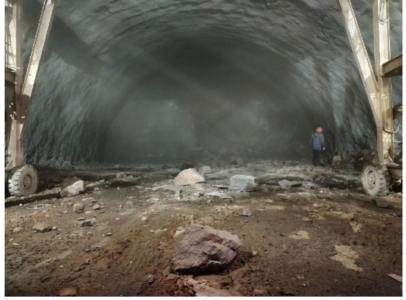
Figure 9. The distribution of rock blocks after rock mass cracking in the test 1.